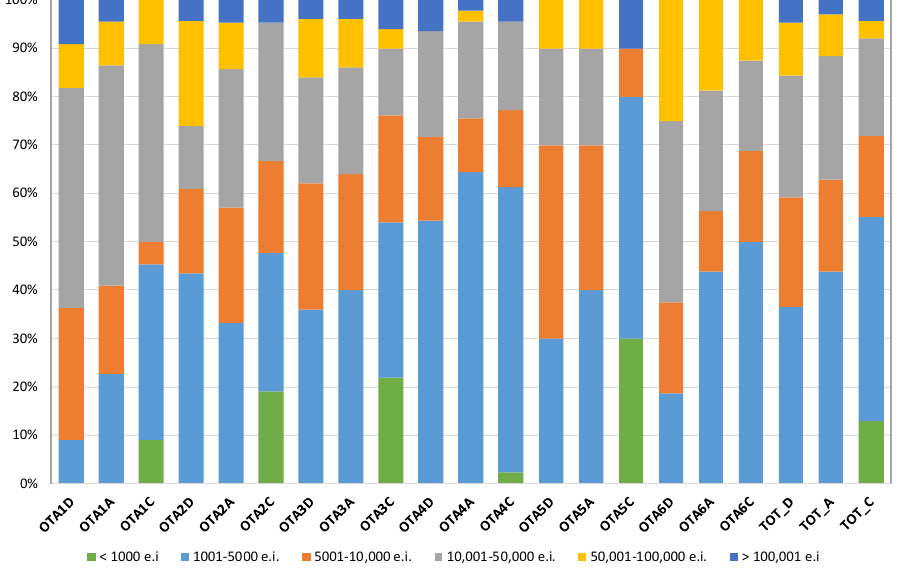
Figure 1. Detailed distribution of the WWTPs in classes of a given design (D), actual (A) or calculated (C) treatment capacity (<5000 e.i., 5001–10,000 e.i., 10,001–50,000 e.i., 50,001–100,000 e.i., >100,000